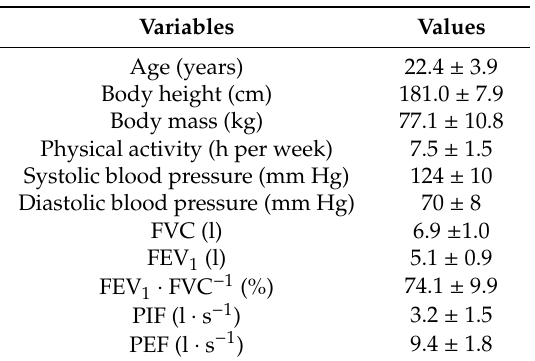
Table 1. Participants’ characteristics ( x ±